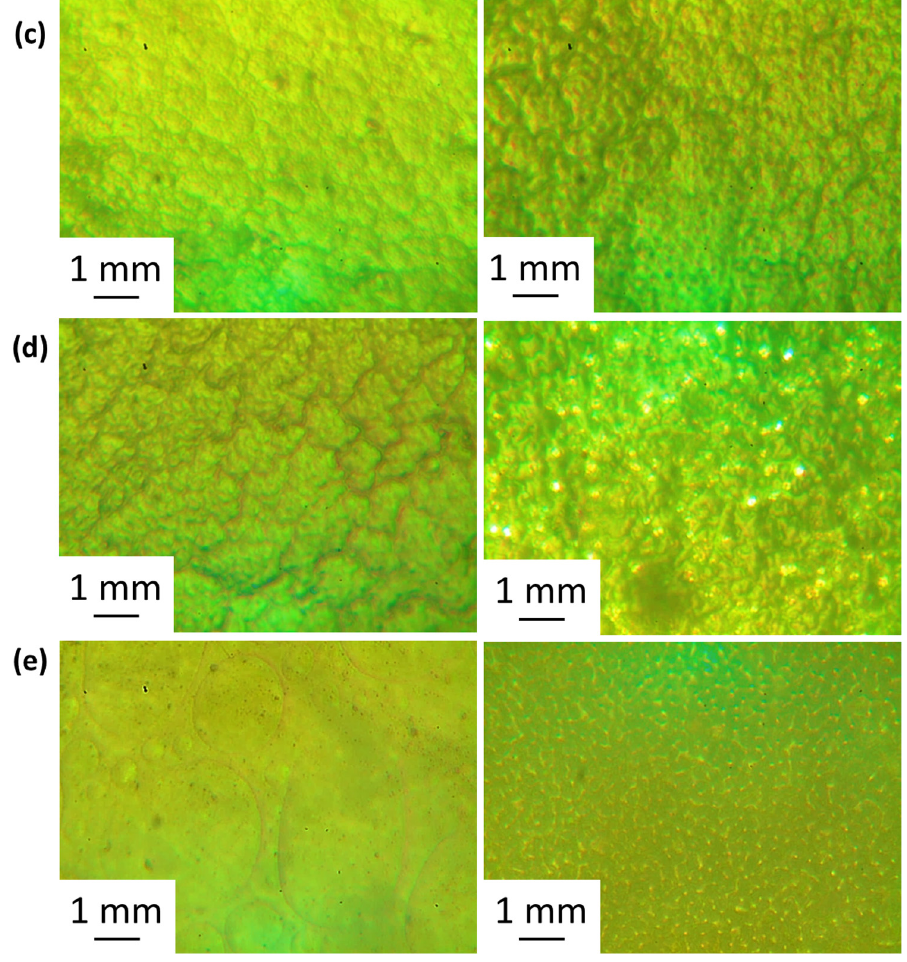
Figure 7. Pre- and post-irradiation (300 h) microscopy images of the films of ( a ): PVC/L/Ti NPs, ( b ): PVC/L/Cu NPs, ( c ): PVC/L/Co NPs, ( d ): PVC/L/Cr NPs, and ( e ): PVC/L/Ni NPs. High-resolution SEM images of the PVC surfaces were also recorded. SEM images tend to be non-distorted and enable a clear assessment of surface irregularity and homo- geneity [61]. In addition, the images provide information about particle size and shape as well as the diameters of pores and grooves and their distribution on the surface. The SEM images recorded for the PVC films after irradiation are shown in Figures 8 and 9. The high rate of elimination of HCl and volatiles from the chains of PVC during irradi- ation forms grooves of varying shapes and sizes [62]. The SEM images show that the surfaces of the PVC blended with Cr and Ni NPs are similar in terms of pores’ shape, size, and